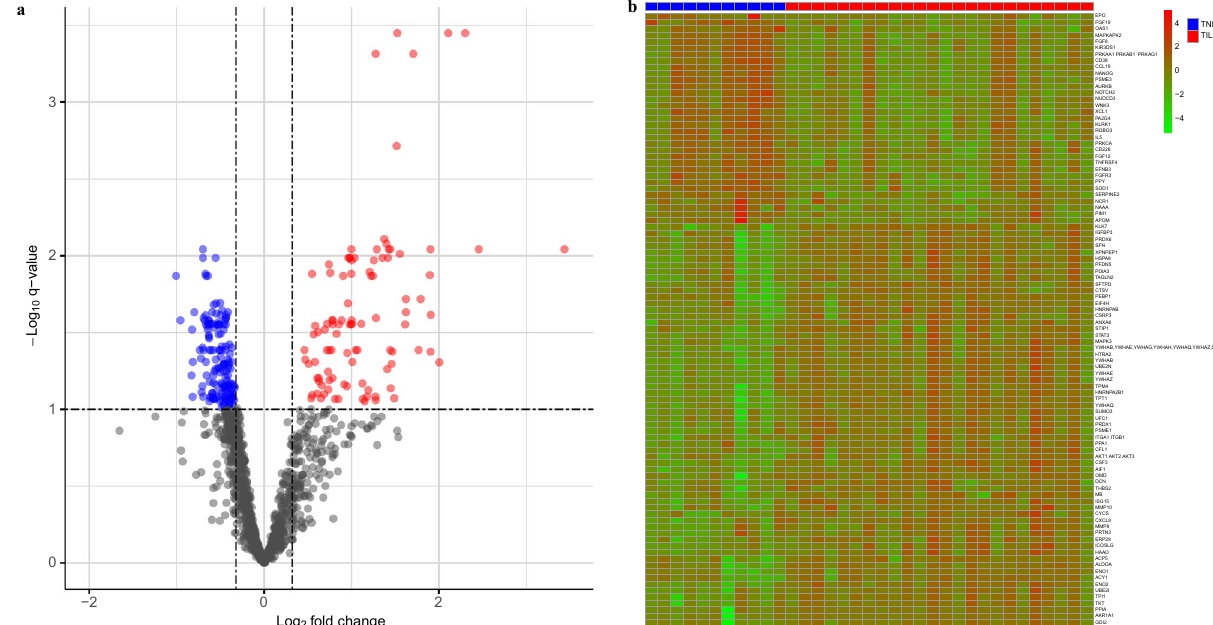
Figure 3. Differential protein abundance in the amniotic fluid with and without labor at term. ( a ) Volcano plot showing log 10 -transformed false discovery rate adjusted p -values (q-values) against log 2 -transformed fold changes of the 1310 amniotic fluid proteins. ( b ) Heatmap based on proteins with significantly altered abundance (q<0.05 and fold change ≥ 1.5) between term not in labor (TNL, indicated by blue headers) and term in labor (TIL, indicated by red headers) samples. The R/Bioconductor packages, EnhancedVolcano 157 and pheatmap 158 , were used to generate the volcano plot and heatmap,